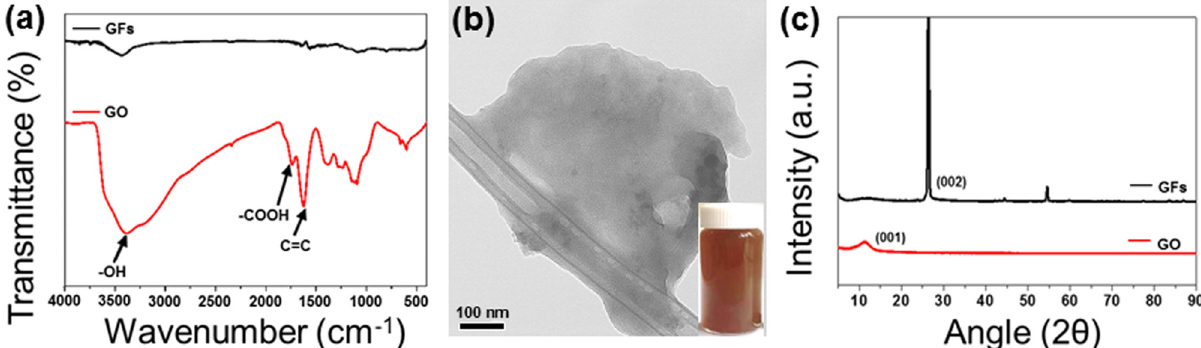
Figure 3: Characterization of GO: ( a ) FT - IR spectra of the GF and GO, ( b ) TEM image of GO ( the inset: photographs of GO suspension in the water ) , and ( c ) XRD patterns of GF and